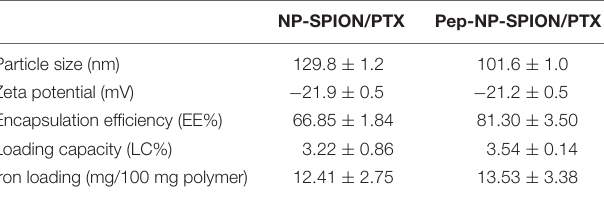
TABLE 1 | Characterization of NP-SPION/PTX and Pep-NP-SPION/PTX.